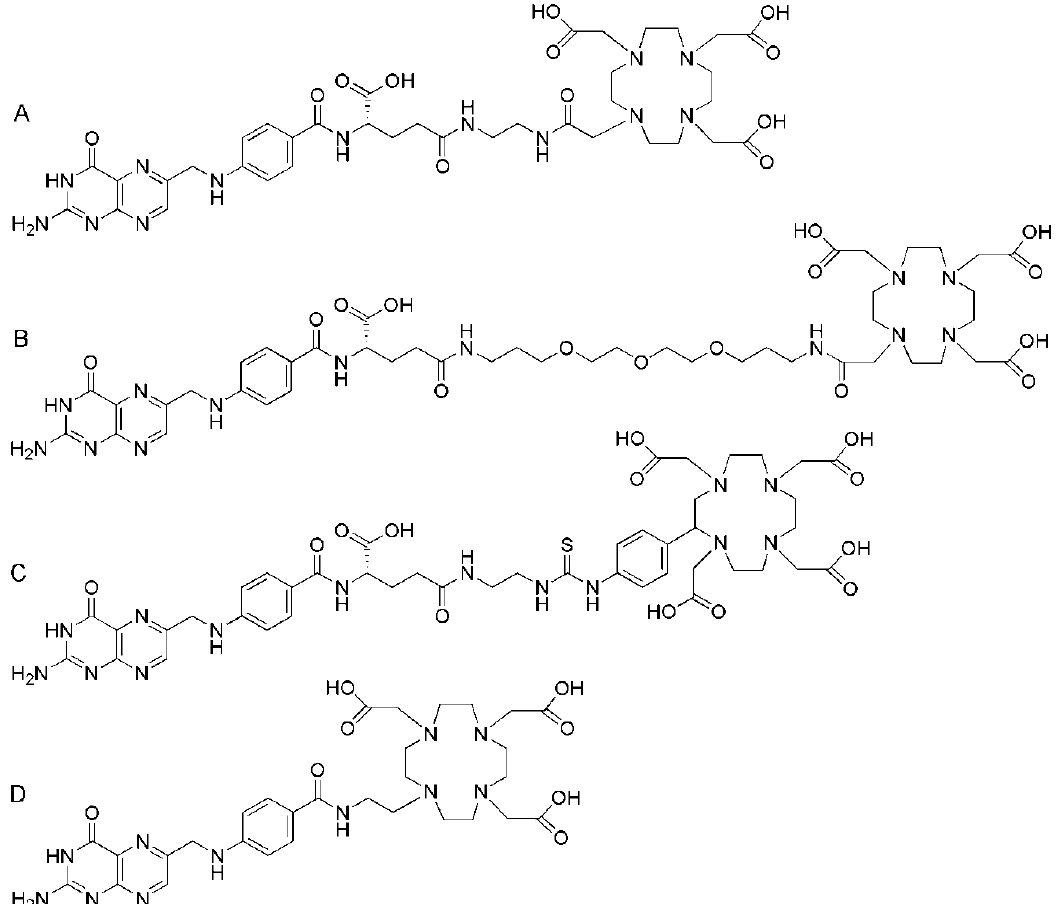
Figure 8. ( A ) Chemical structures of the DOTA-folate P3026 [50], ( B ) the DOTA-folate P1254 which comprises a short PEG spacer [50], ( C ) EC0800 (Endocyte Inc., West Lafayette, IN, USA) [85] and ( D ) DO3A-pteroate [86].